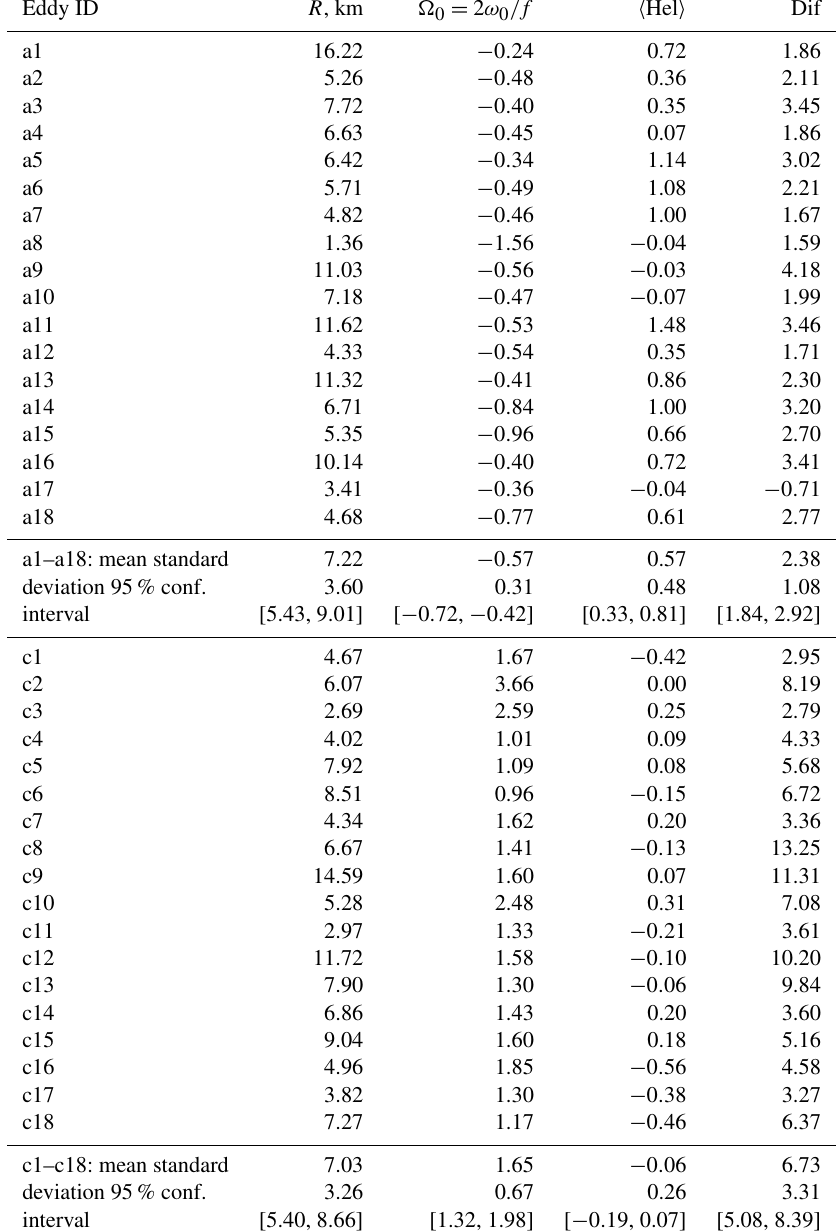
Table A1. Rotary characteristics of submesoscale cyclonic and anticyclonic